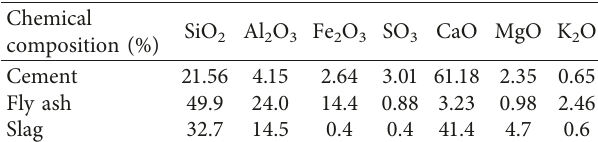
Table 1: Percentage chemical composition of cement, fly ash, and